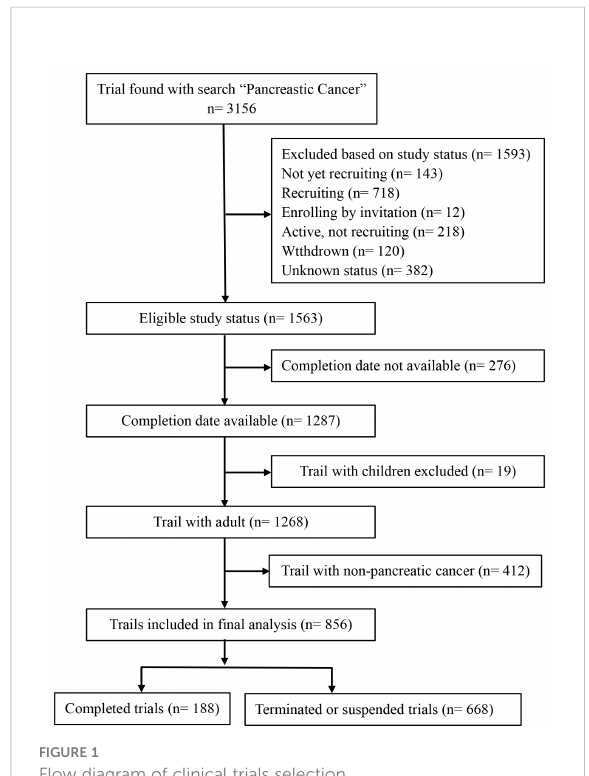
FIGURE 1 Flow diagram of clinical trials